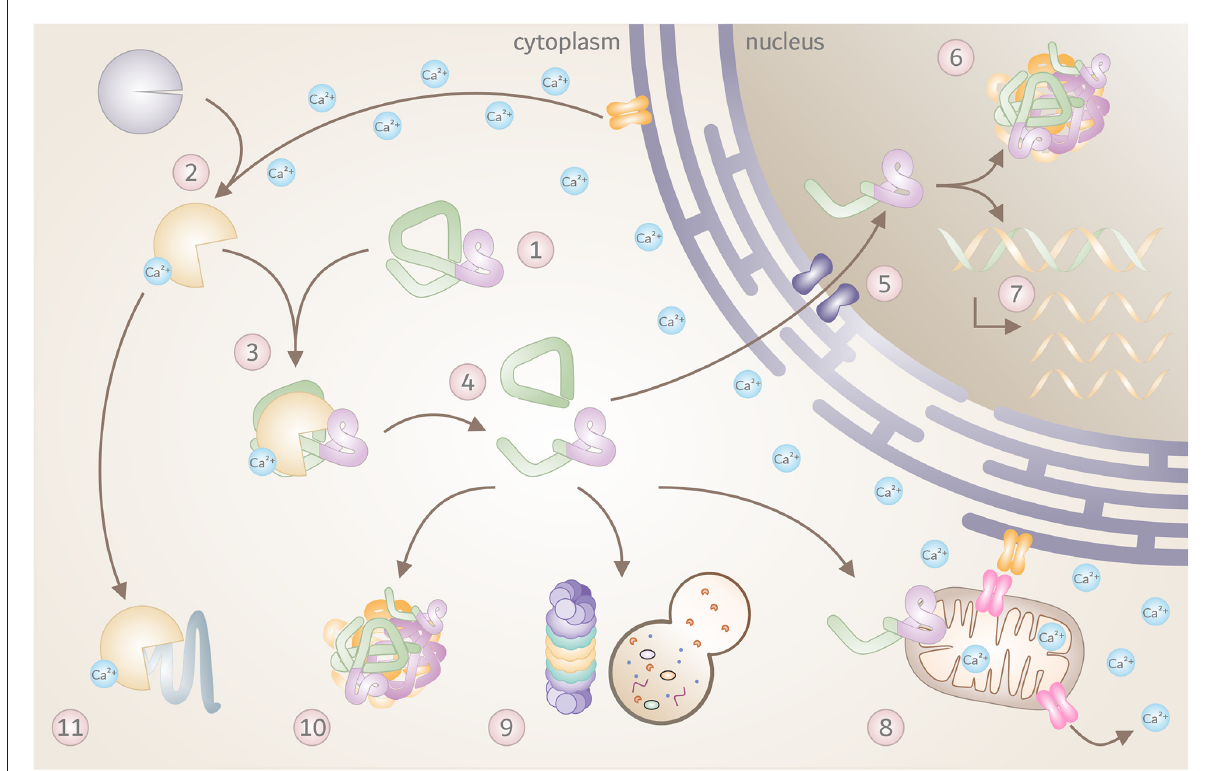
FIGURE3 The toxic fragments hypothesis in the molecular pathogenesis of polyQ disorders. Overview of known molecular and cellular repercussions in the context of the pathomechanism of Huntington disease (HD), Machado-Joseph disease (MJD), and spinocerebellar ataxia type 17 (SCA17), with a potential (yet unconfirmed) general validity for all polyQ disorders and beyond. (1) PolyQ disorders are caused by mutations that result in a pathologically elongated polyQ tract (highlighted in pink) in the respective disease protein, such as HTT, Atx3 or TBP. (2) Due to a pathology- related dysregulation of the cellular calcium homeostasis, calpains become overactivated, and (3) engage in cleaving mutant proteins. (4) This process results in the formation of toxic disease protein fragments containing the polyQ stretch. (5) Breakdown products can translocate to the cell nucleus, (6) and accumulate, forming intranuclear inclusions which sequester important nuclear components. (7) This process may interfere with transcription, leading to disturbed gene expression. In addition, disease protein fragments can cause (8) mitochondrial dysfunction and stress, leading to further calcium disbalance and calpain activation. Disease protein fragments can, furthermore, (9) impair protein clearance mechanisms, including autophagy and proteasomal degradation, (10) triggering the formation of cytoplasmic aggregates and inclusion bodies. (11) Finally, pathologically overactivated calpains may contribute to excessive cleavage of other cellular proteins with negative effects on cell function and